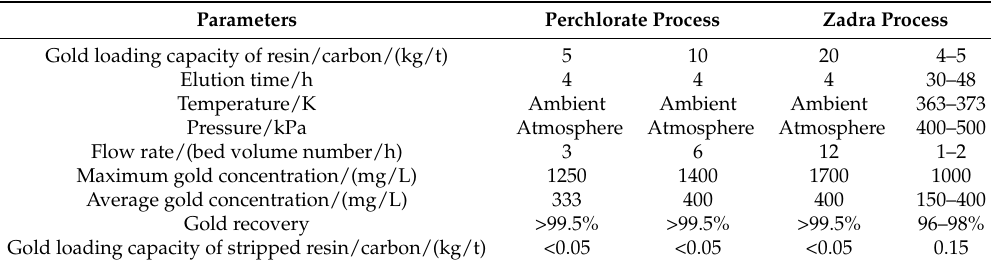
] 3 − anion elution from the resin by the perchlorate process 2